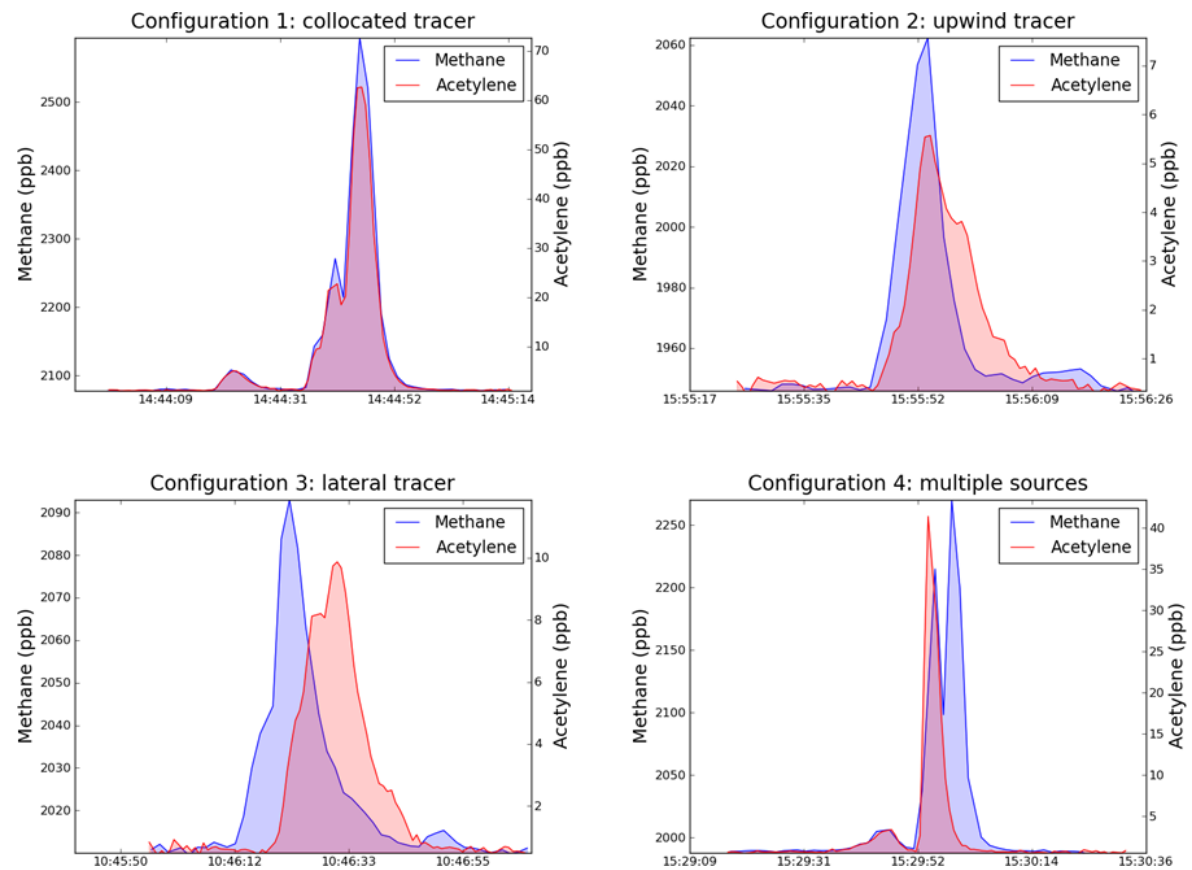
Figure 5. Examples of cross sections of the measured emission plumes of acetylene and methane (in red and blue) for each configuration. Table 2. Methane emission rates of the different controlled release configurations estimated with the different approaches and methane fluxes actually emitted during these tests. The uncertainties given with the tracer release method are detailed as follows: standard deviation of the random uncertainty derived from the variability in the results from one transect to the other one (bias due to the mislocation of the tracer; total